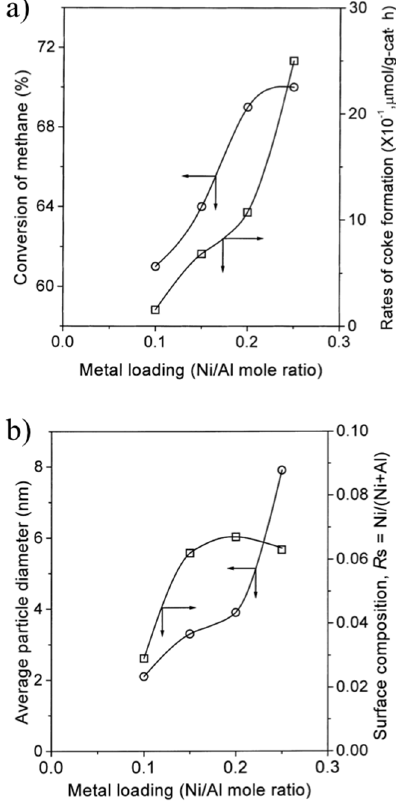
Figure 5. ( a ) Catalytic activity and the rate of coke formation, and ( b ) the particle size and the surface composition of Ni ‐ alumina aerogel catalysts as a function of metal loading. The average particle size and surface composition were determined by TEM and XPS, respectively. The rate of coke formation was estimated from the total carbon contents in the spent catalysts. Reprinted with permission from Ref. [63]. Copyright (2000)